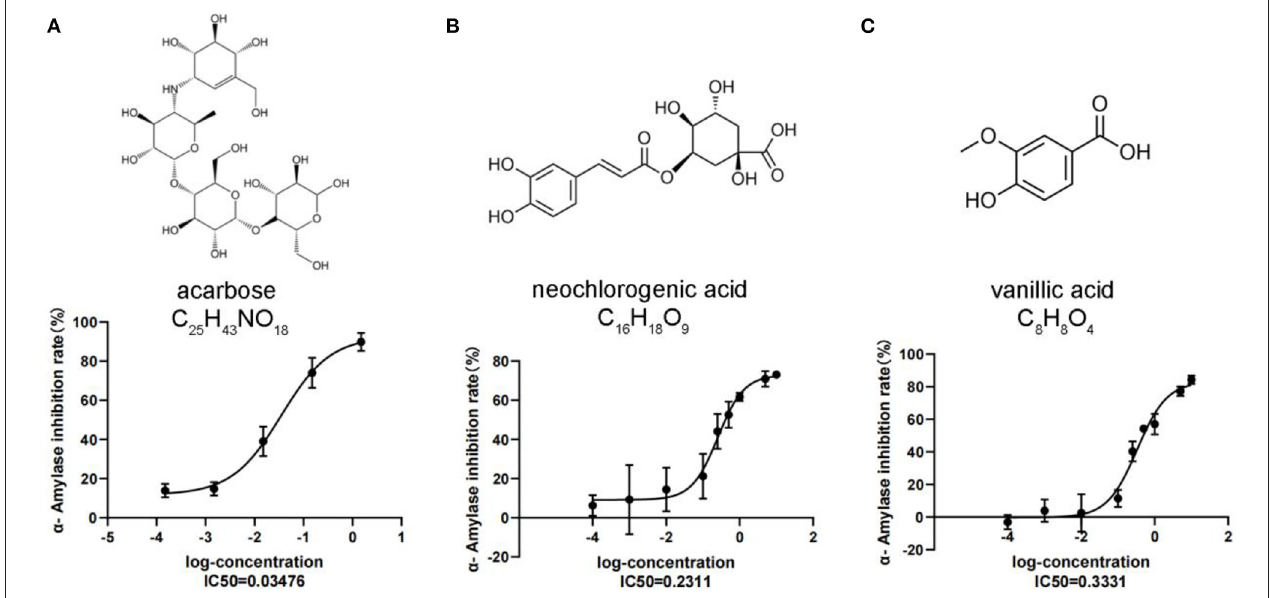
FIGURE 4 | Alpha-amylase inhibitory assay of DAMs. (A) Acarbose. (B) Neochlorogenic acid. (C) Vanillic acid. Each value represents the mean ± SD, and error bars represent significant differences ( n = 3, P < 0.05).